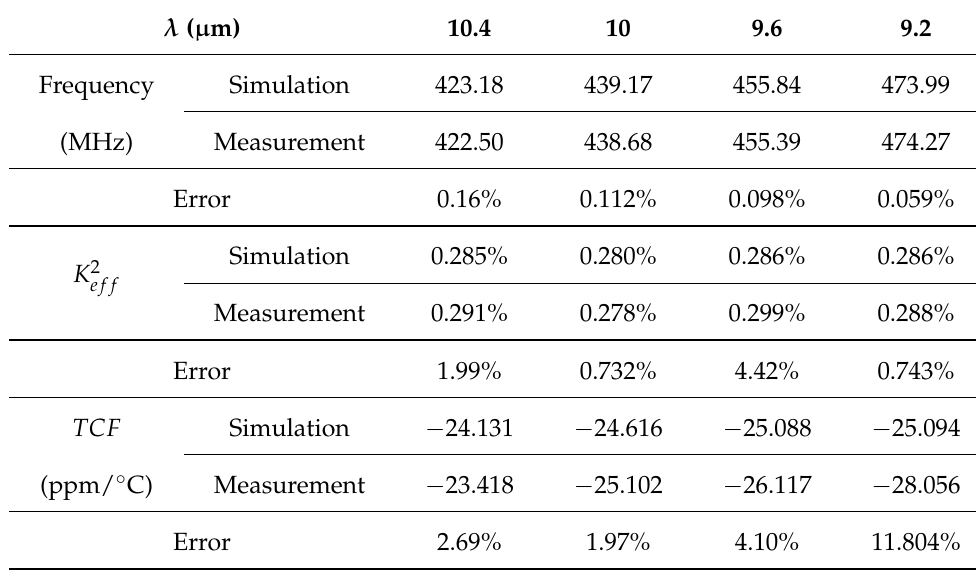
Table 3. Comparison of simulation and measurement